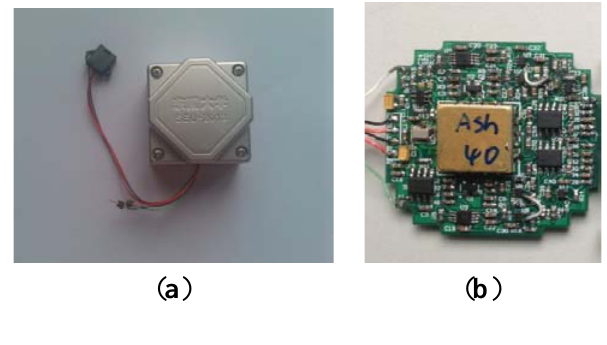
Figure 17. ( a ) The laboratory prototype of the micromechanical silicon resonant accelerometer; ( b ) The circuit module inside the